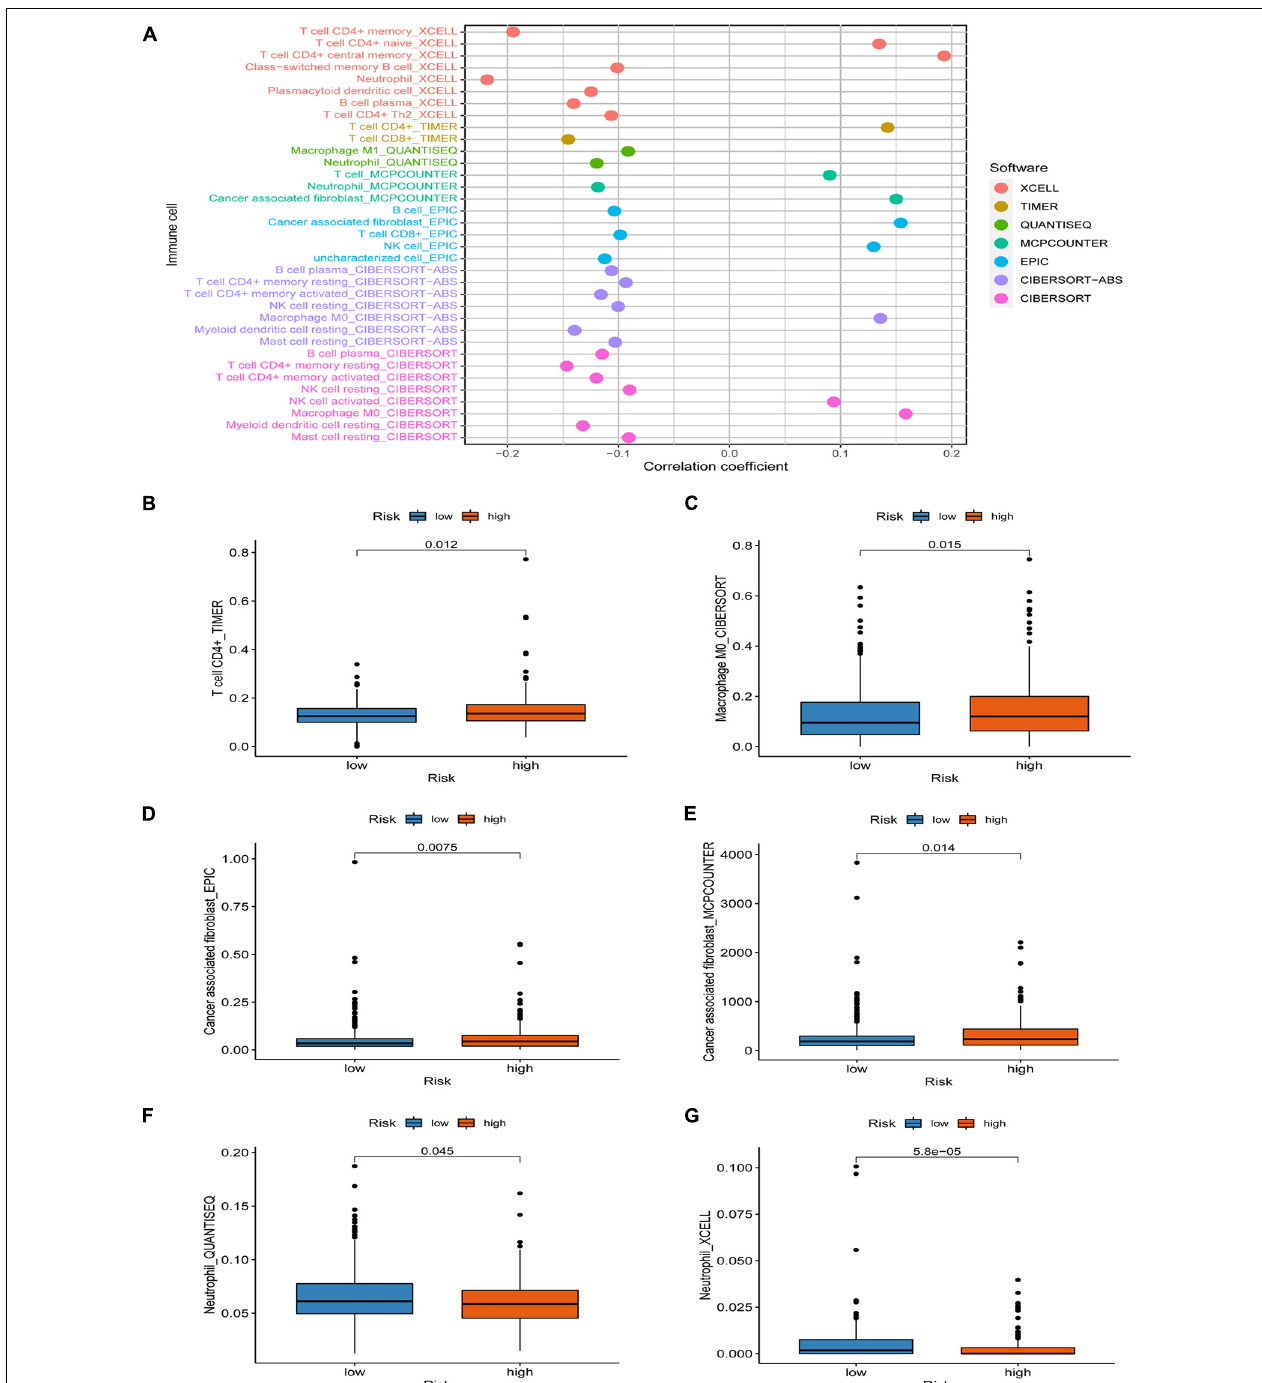
FIGURE 5 | Association between immune cell infiltration and the risk score. (A) The relationship between risk score and immune infiltrating cells in multiple databases. (B–G) High risk was positively correlated with tumor-infiltrating immune cells such as CD4 + T cells, macrophage, and cancer-associated fibroblast, whereas negatively correlated with